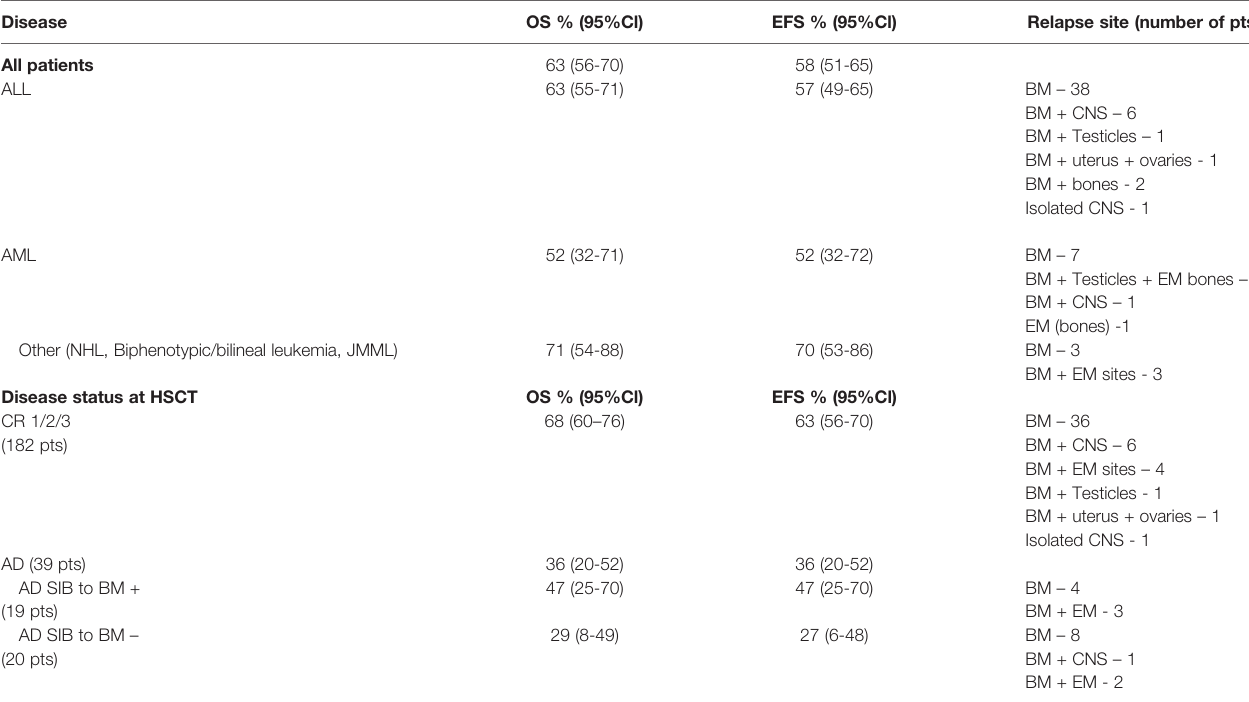
TABLE 7 | The survival analysis results for the different patient